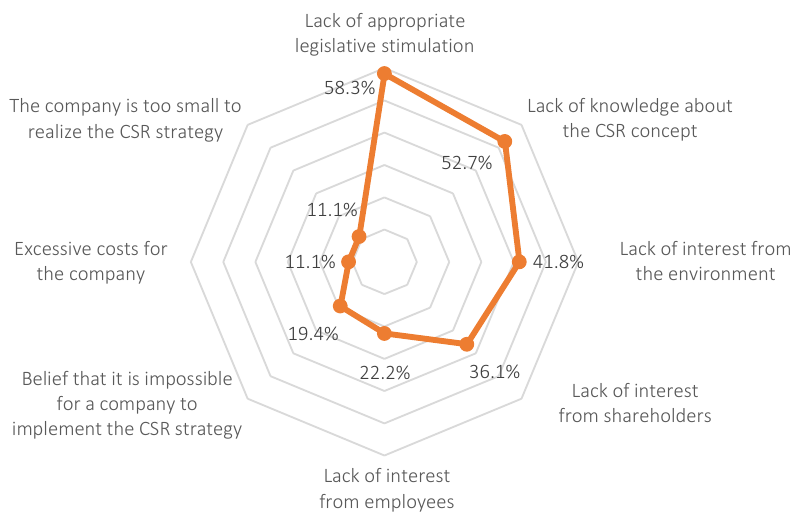
Figure 6. The reasons for the lack of implementation of the CSR concept in insurance